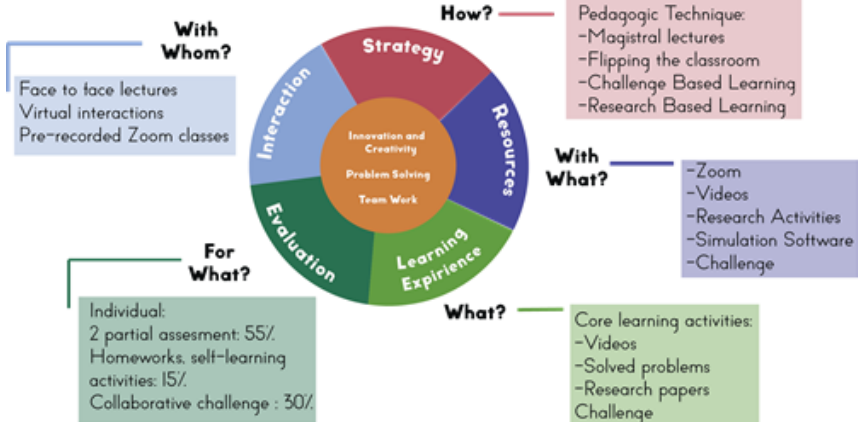
Figure A1. Elements of the Massive Flexible Digital Masterclass (MFDM) pedagogic